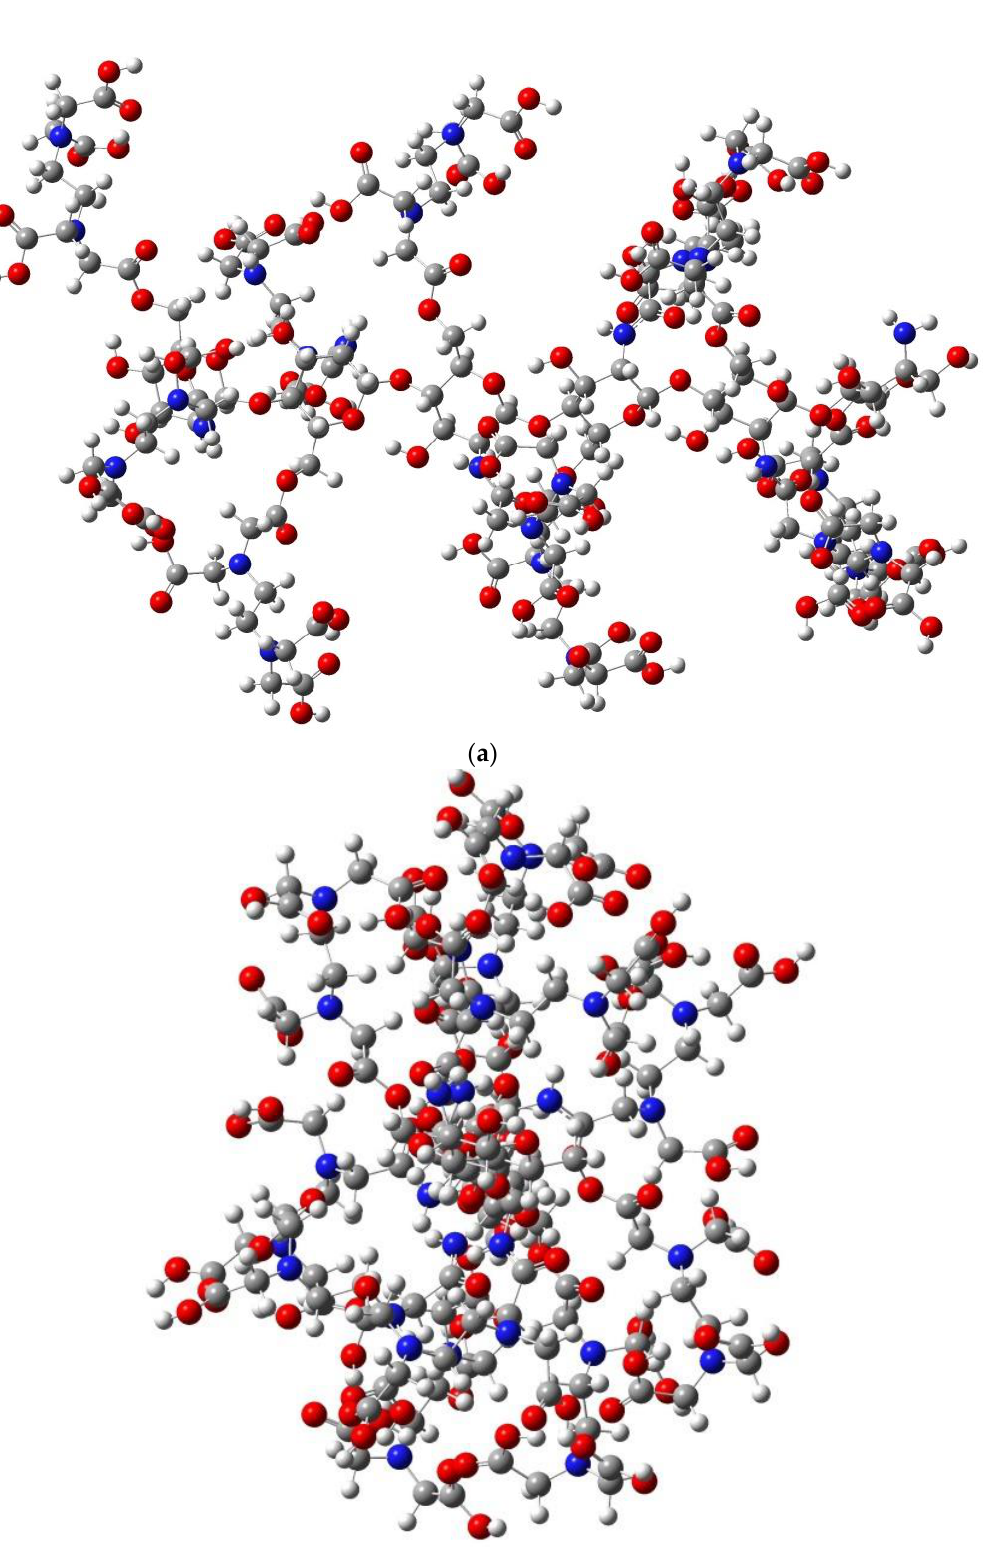
Figure 11. Spatial representation of a structure consisting of six CS units with EDTA grafted alter- nately to the N atom of the amino groups and the O atom of the hydroxymethyl groups: ( a ) along the chain; ( b ) perpendicular to the chain. ( b ) perpendicular to the